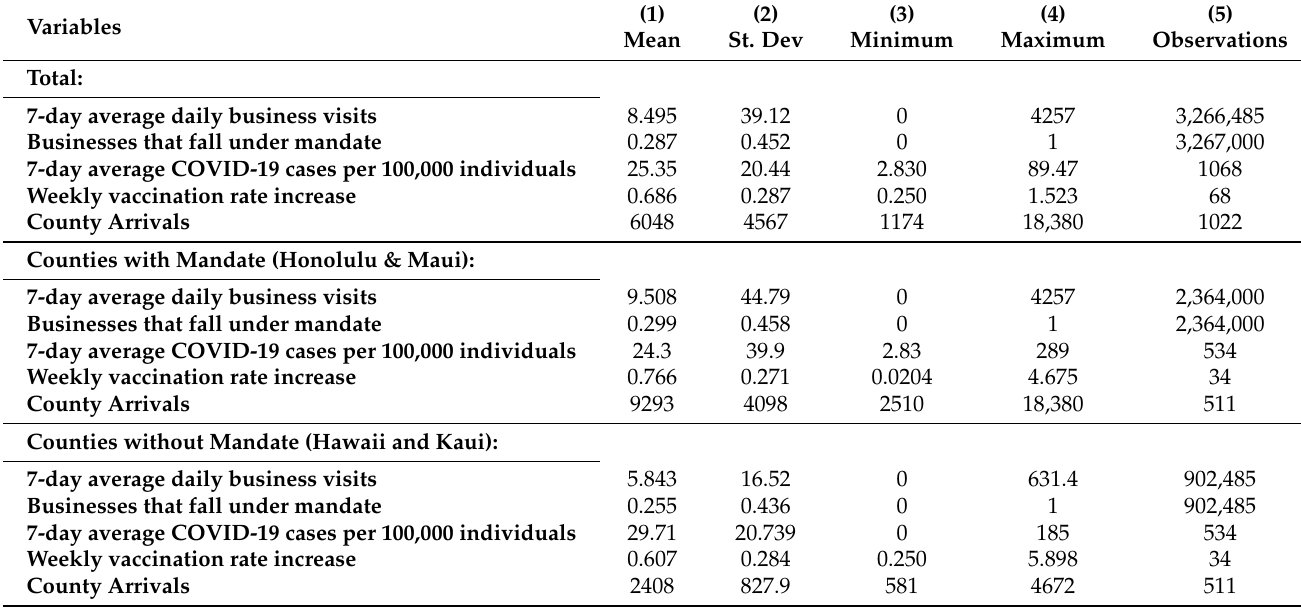
Table 1. Summary statistics for the total sample and sub-sampled by the counties with and without vaccine mandates. Businesses in categories that fall under the mandates include those in the food and beverage, fitness, and entertainment industries. Statistics are for the entire sample period, before and after the mandates’ announcements and implementation. Estimates for businesses, COVID-19 cases, and county arrivals are estimated on a 7-day-rolling-average basis for each day, and vaccination rate increases are for each week. The observations column represents the total number of observations included in the